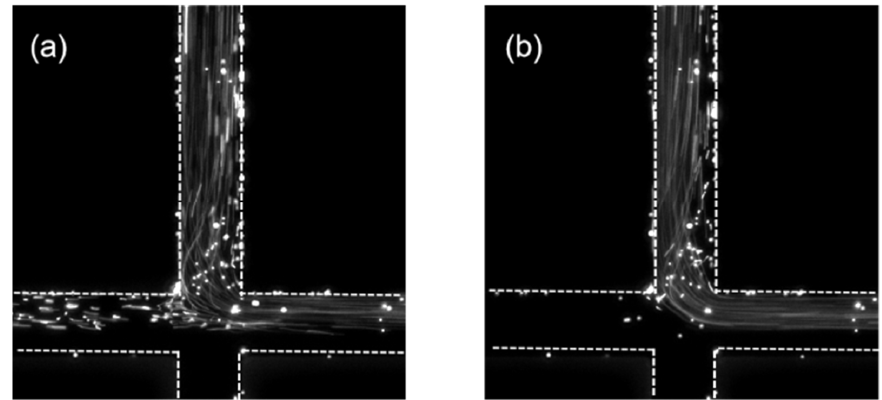
Figure 4. PAM flow pattern in the SCM at ( a ) Wi = 2.78 and ( b ) Wi = 5.56.